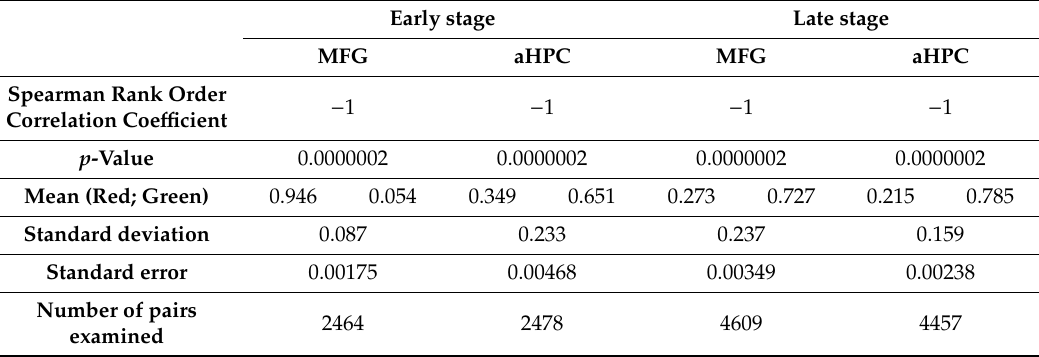
Table 2. Statistical analysis of lemur tyrosine kinase 2 (LMTK2) (red)/phospho-tau (green) fluorescent signal correlation in the middle frontal gyrus (MFG) and anterior hippocampus (aHPC) in early and